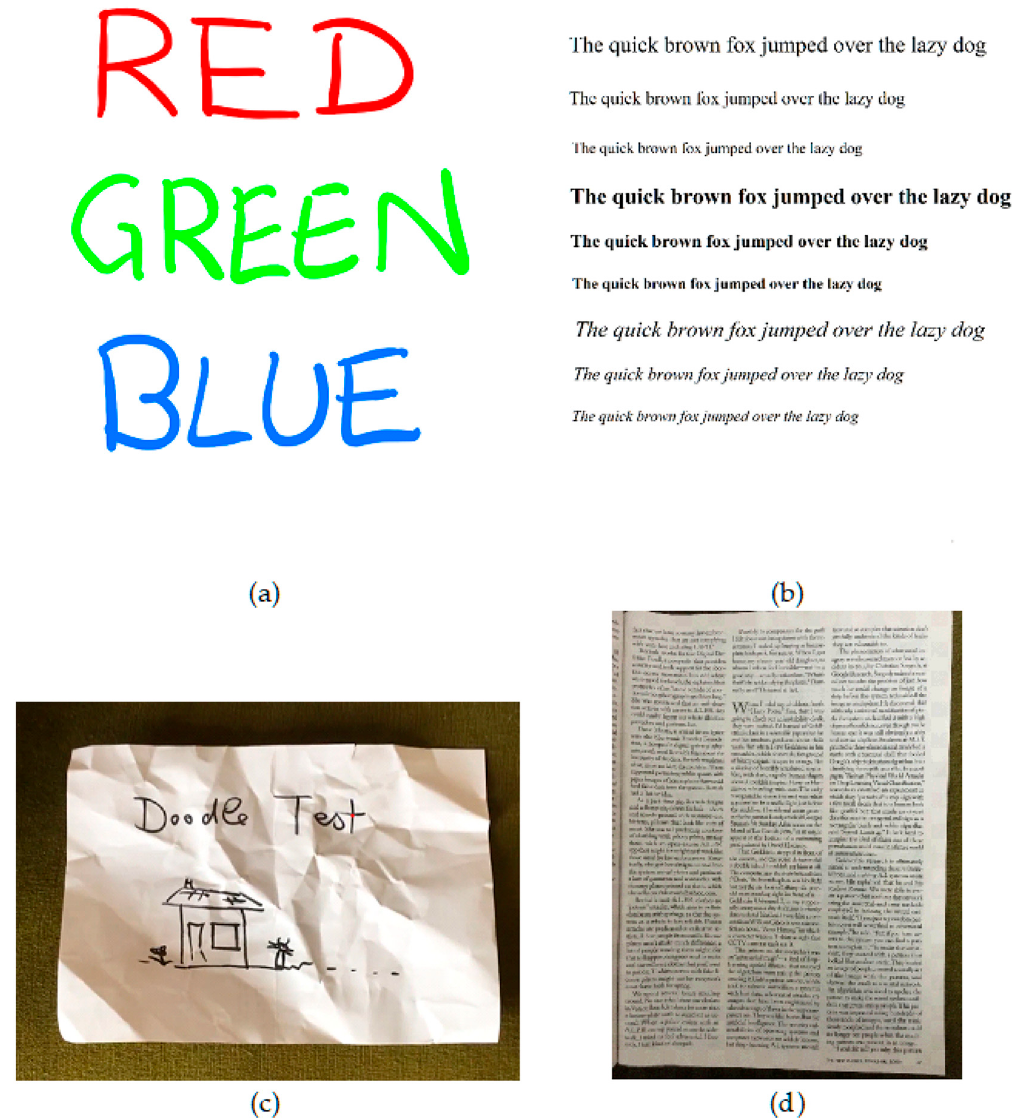
Figure 2. Sample test images from each dataset. (Note: real paper images are shown as photographs here). ( a ) A synthesized color reference image; ( b ) a synthesized text reference image; ( c ) a sketch on crumpled paper; ( d ) a sample of text on a page.